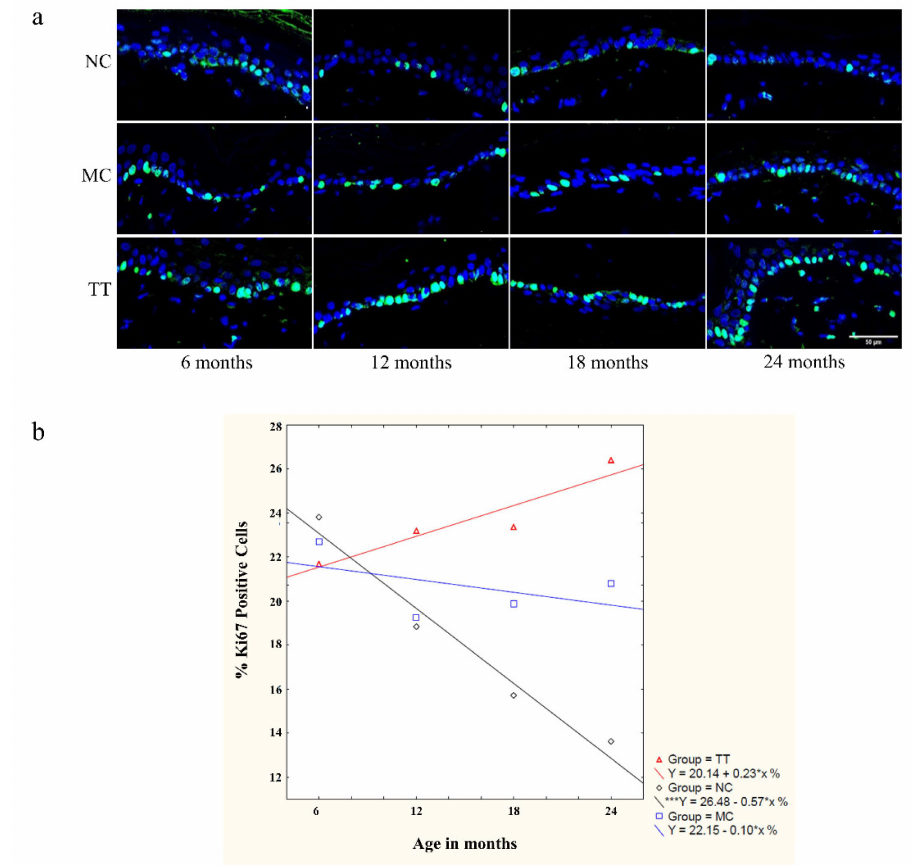
Figure 5. The positive effect of implanted young fibroblasts on stem cell niche is stronger with advancing age. ( a ) Cell proliferation status in rats aged 6, 12, 18, and 24 months (NC-untreated control; MC-mechanical treatment control; TT-young cells implantation treatment). Ki67 positive stem and cycling cells (green) on the basement membrane of the epidermis. Scale bar is 50 µ m. ( b ) The graph represents the percentage of Ki67 positive cells on the basal membrane of the epidermis with advancing age for untreated tissue (black diamond), mechanical treatment (blue square), and tissue treated with young fibroblasts (red triangles). n = 6 for 6, 12, and 18 months; n = 5 for 24-month-old animals; error bars represent mean ± 0.95 confidence intervals; *** p <